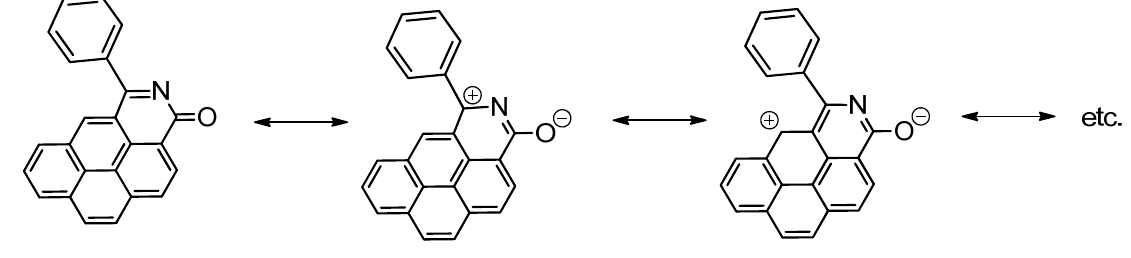
Figure 6. Resonance structures of 7 .